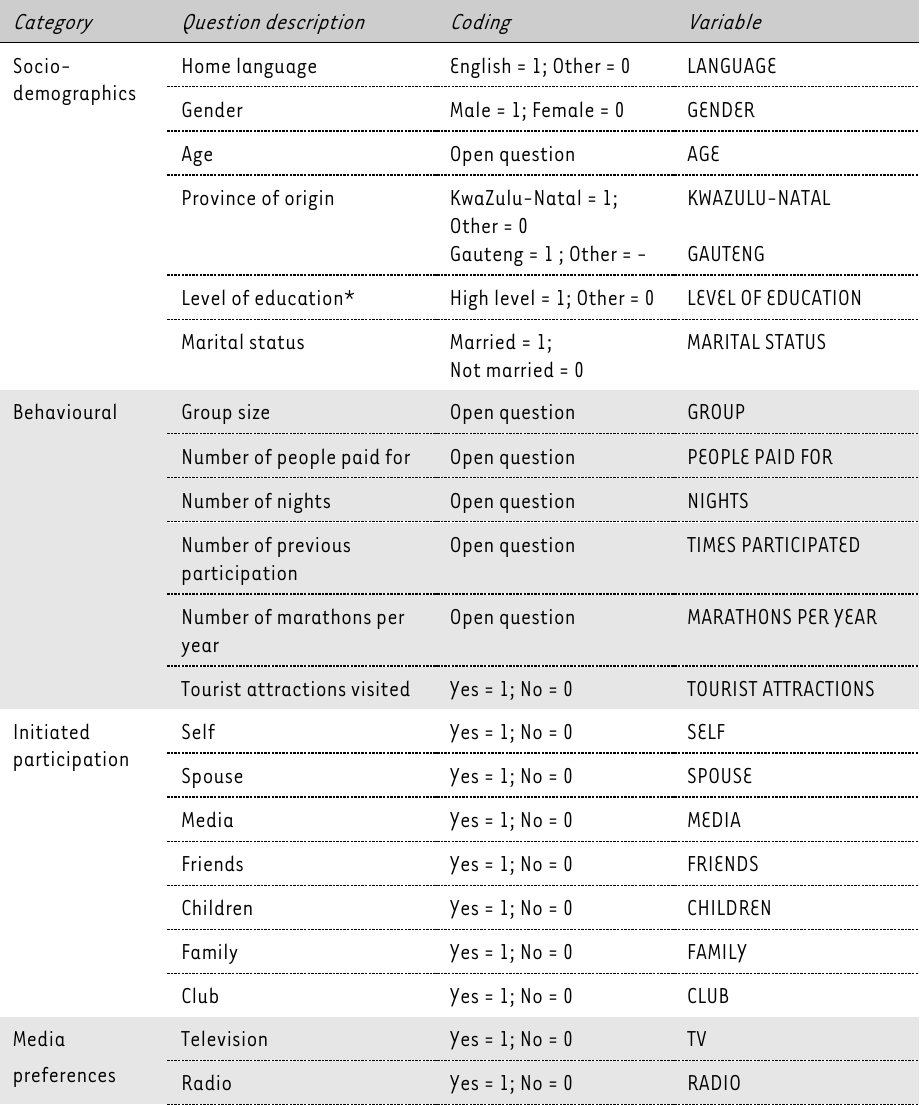
TABLE 4: Categories of questions asked for the ‘up’ and ‘down’ runs of the Comrades Marathon